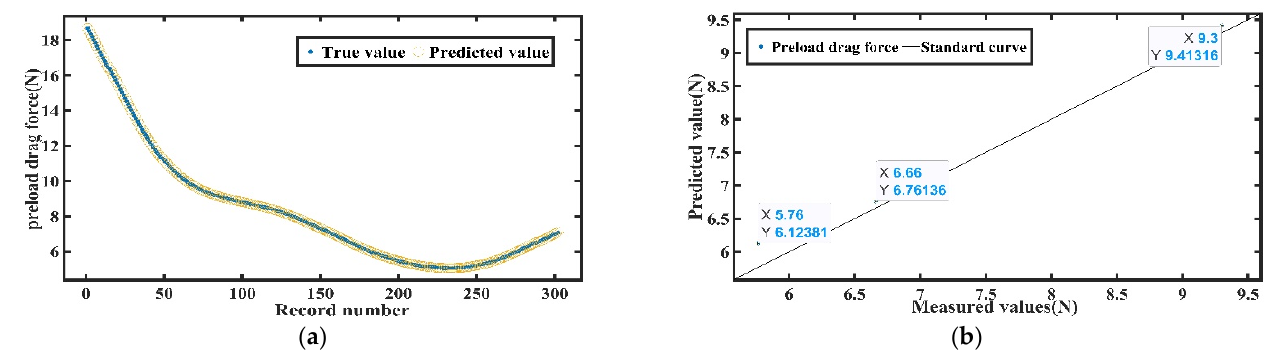
Figure 16. The training results and test results of the model. ( a ) Training results, ( b ) Testing results.